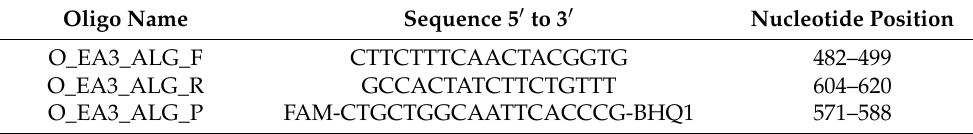
Table 2. Primers and probe for the real-time RT-PCR designed for the detection of topotype O/EA3 from Algeria (GenBank accession number